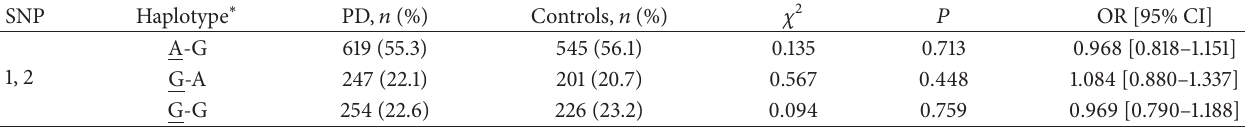
Table 5: Haplotype frequencies in Han Chinese with PD and in healthy